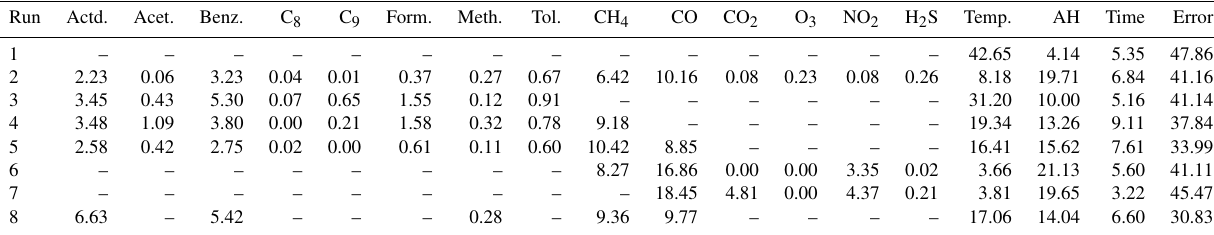
Table 5. Analysis of variance results for the Figaro 2600 sensor signal ( R s /R 0 ). Run Actd.